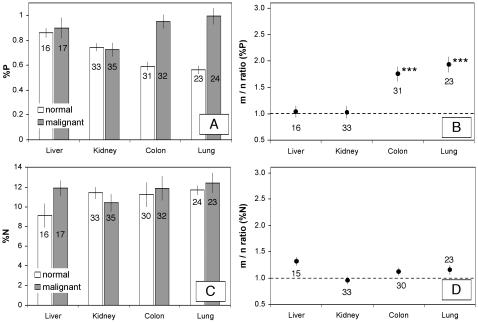
Absolute and relative values for elemental composition in normal and malignant tissues of liver, kidney, colon, and lung.A. and B. P content. C. and D. N content. The number of observations contributing to each mean is given by the number associated with each bar or point. Data in the right hand panels are expressed as the mean of the patient-specific ratios of malignant relative to normal tissue values (m/n ratio) for each parameter. The horizontal line shows an m/n ratio of one, indicating no difference between malignant and normal tissues. Error bars indicate±one standard error. Asterisks next to each symbol in the right hand panels indicate the results of the organ-specific t-test examining whether the m/n ratio differs from one for that organ (*** = p<0.0001; ** = 0.0001<p<0.001; * = 0.001<p<0.05; no asterisk = non-significant).